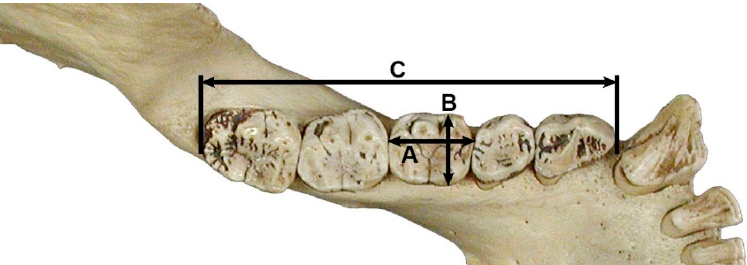
Figure 3. Example of three dental dimensions commonly used for estimating body mass using re- gression methods, illustrated on the left hemimandible of Gorilla gorilla . A = mesiodistal diameter of first molar; B = buccolingual diameter of first molar; C = mandibular post-canine tooth row